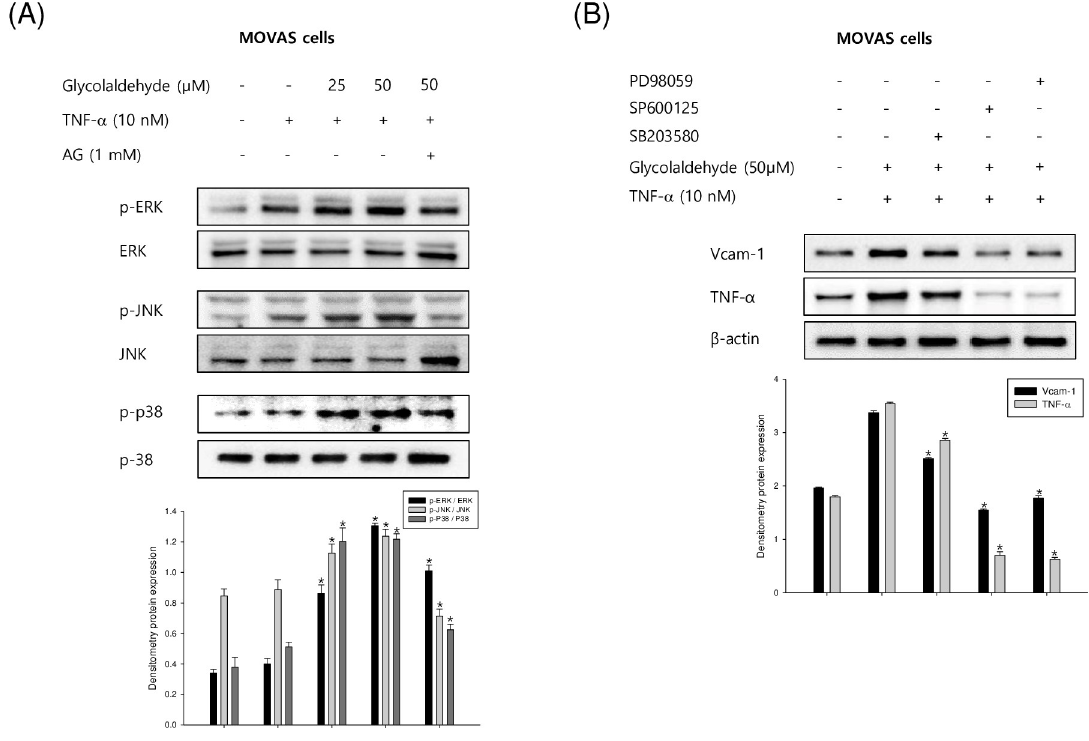
Fig 4. Effects of GA on the phosphorylation of MAPKs in TNF- α -stimulated VSMCs. (A) The mouse VSMCs, MOVAS-1 cells, were incubated with TNF- α (10 ng/mL) in the presence or absence of GA (25 and 50 μ M) for 30 min. (B) MOVAS-1 cells were incubated with GA and TNF- α (10 ng/mL) in the presence or absence of the ERK1/2 inhibitor PD98059 (20 μ M), the JNK inhibitor SP600125 (10 μ M), and the p38 MAPK inhibitor SB203580 (10 μ M). MAPKs protein levels were determined by western blot assay. Results are shown as means ± SEM from a representative experiment (n = 5). � p < 0.05 significantly different from the group treated with TNF- α